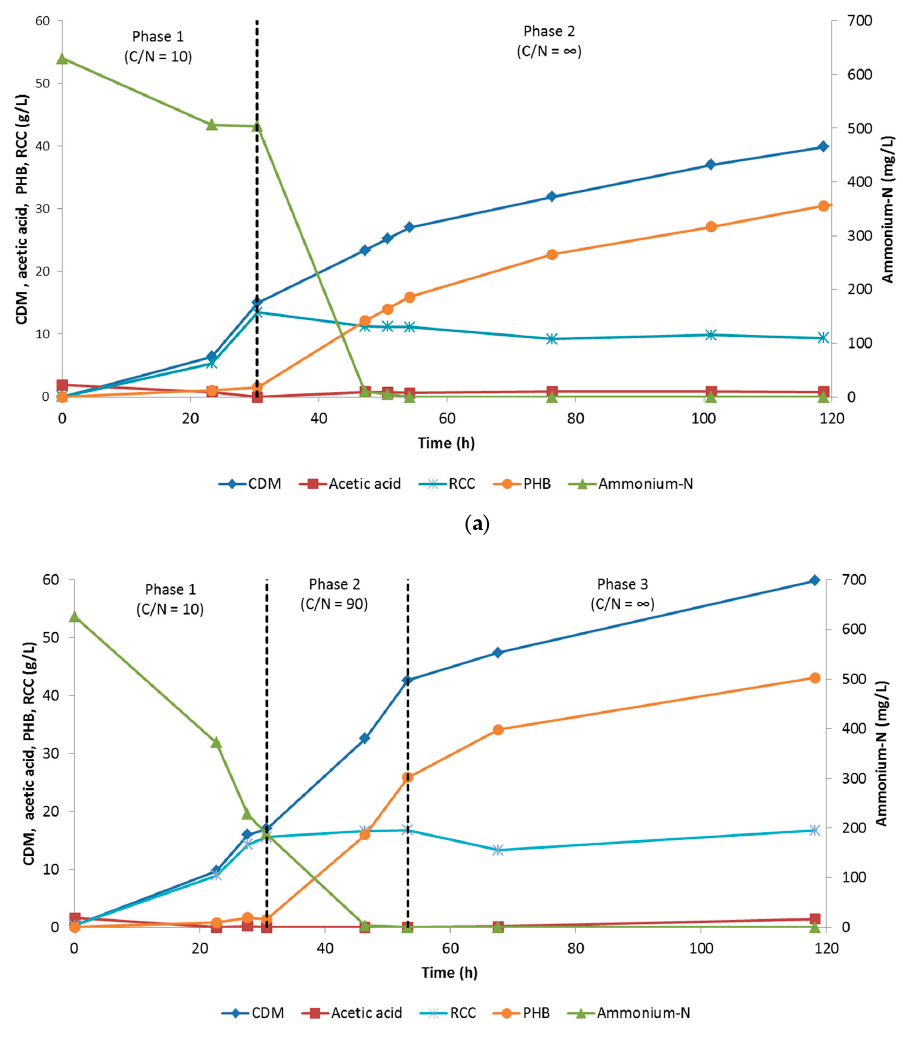
Figure 2. Fed-batch fermentation of C. necator for PHB production using acetic acid as carbon source. The accumulation of biomass (CDM), PHB, residual cell concentration (RCC) and acetic acid concentration over time of fermentation are shown. ( a ) Two-phase feeding strategy; ( b ) Three-phase feeding strategy.